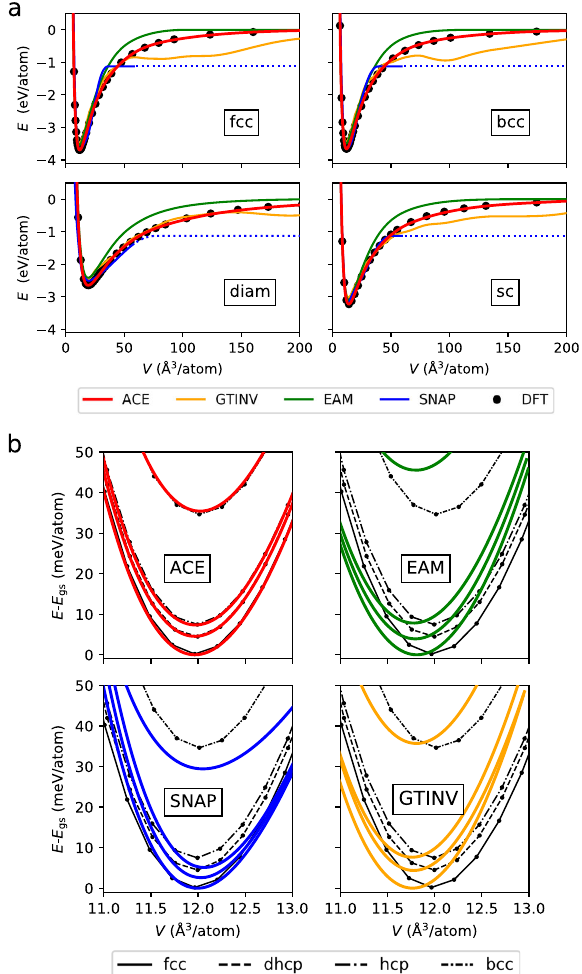
Fig. 2 Energy vs. volume for Cu. a Wide volume changes for fcc, bcc, diamond, and simple-cubic crystal structures. The SNAP cohesive energy was adjusted by a constant shift to match the fcc DFT data. b Low-energy bulk phases. Lines with symbols correspond to DFT reference